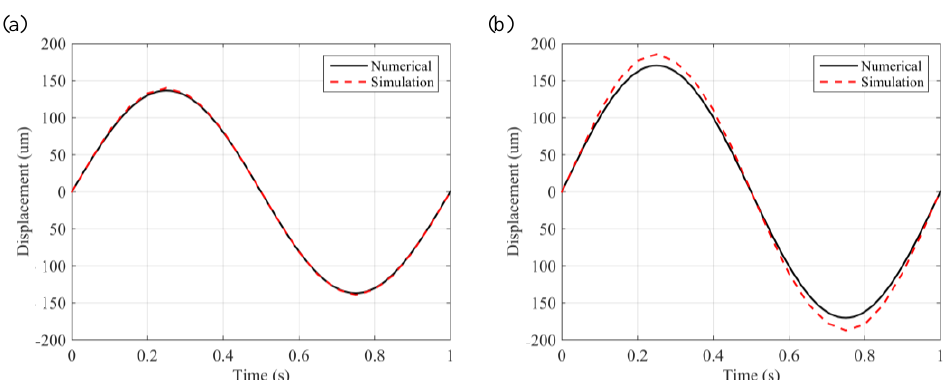
Figure 7. Displacement–time diagram of the transient analysis of the ( a ) plain microcantilever and ( b ) perforated microcantilever.